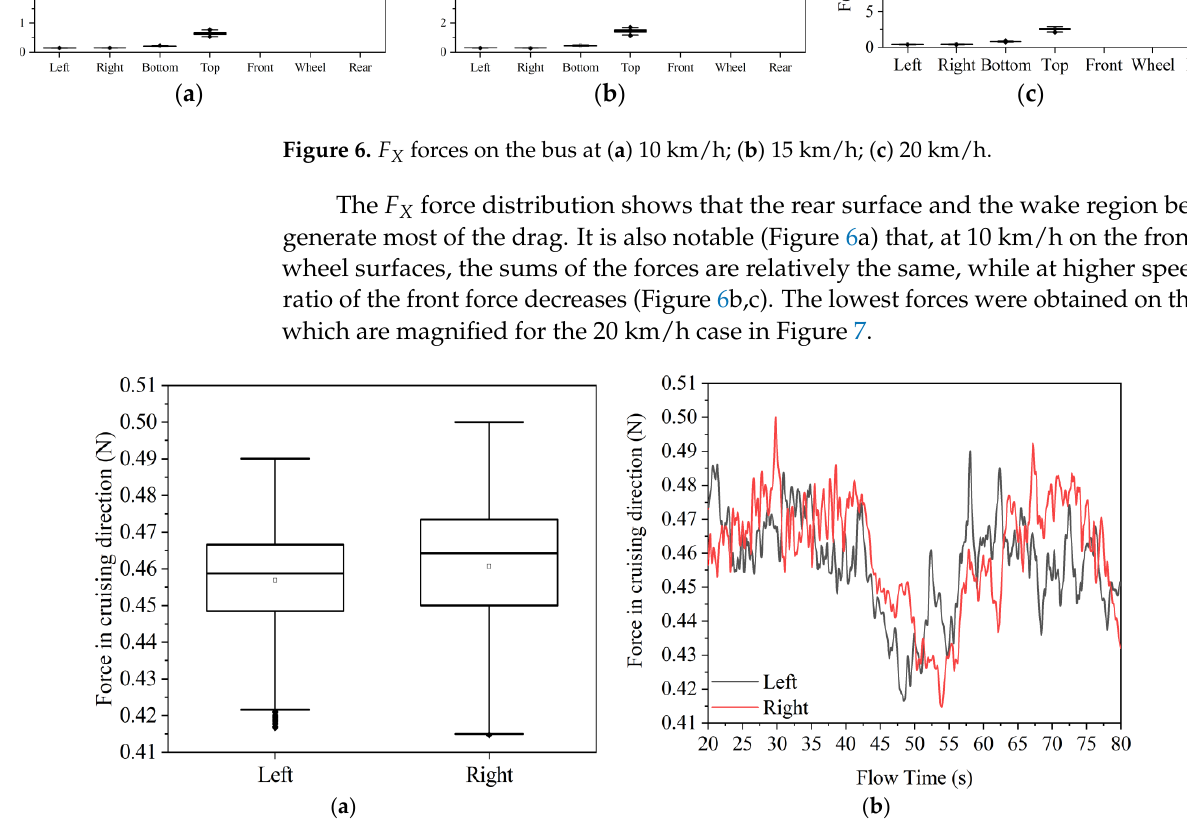
Figure 7. ( a ) F X forces on the side of the bus at 20 km/h box plot; ( b ) force – time connection. The mean values are close to each other; however, the deviations are slightly higher on the right side. To examine it more closely, the F X and time connection is also plotted in Figure 7b. The two forces are altering symmetrically with a wavy trend. It could also be noted that on the right side, the increased deviation is due to the F X jump at the 30th sec- ond. The regression of the F X fluctuations, showed an R 2 = 0.43 when it was examined for the sine function. Thus, further analyses were not made. Since consistent stochastic devi- ations were present, after the discussed values, the standard deviations were also added. 3.2. Asymmetric Flows Before the analysis of the asymmetric flows, a comparison was made to determine the difference between symmetric and asymmetric simulation when on the sides — first symmetric and then inlet and outlet boundary conditions were used. The side wind blew on the left side of the bus. The sum of the F x forces for both sides is presented in Table 3, together with their standard deviations. Table 3. F X on the left and right sides with different side-wind boundary conditions. Side-Wind Condition